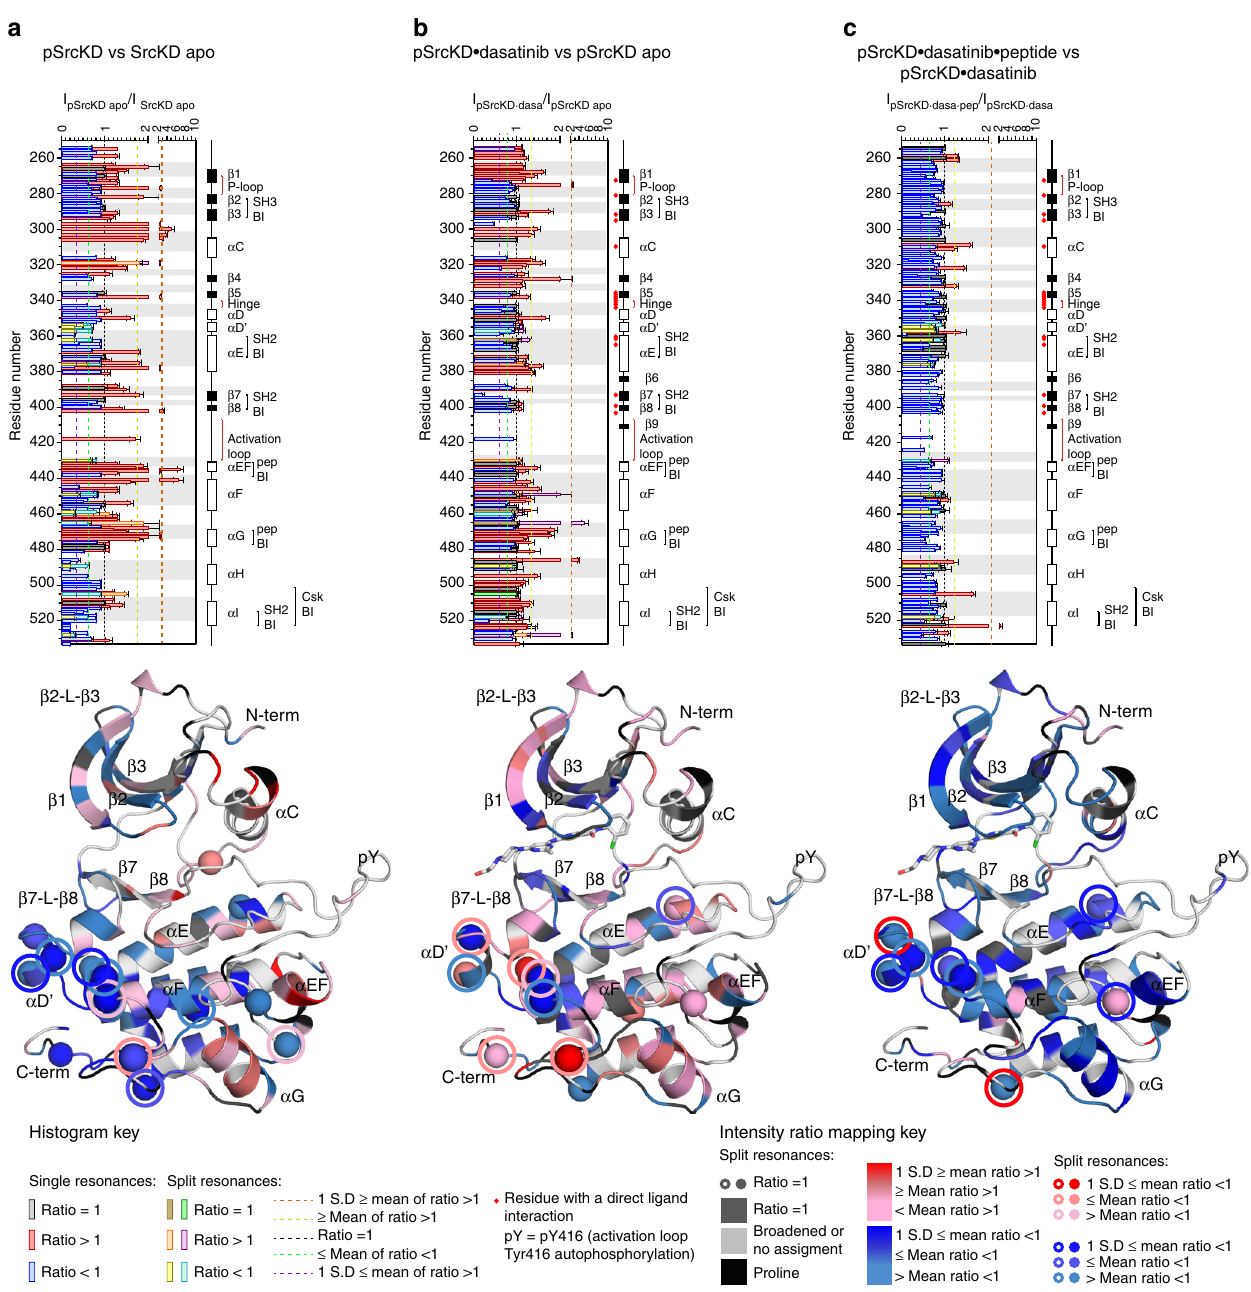
Fig. 6 Signals promoting the active conformation induce long-range dynamic changes. Backbone amide resonance intensity ratios of active SrcKD states formed upon: a activation loop autophosphorylation, ( b ) plus dasatinib, binding c plus substrate peptide binding, were analyzed by histograms and by structure mapping (PDB-entry 3G5D, 4YBJ, 4YBK) 30,31 to infer dynamic changes and interpreted as in Fig. 3. Spheres and circles denote split resonances (Supplementary Table 3). Activation loop autophosphorylation causes long-range sharpening and broadening affecting regulatory sites. Dasatinib induces additional sharpening to activation loop autophosphorylation in some regions, while in other regions it sharpens regions previously broadened by activation loop autophosphorylation. Peptide binding induces overall broadening, reverting the sharpening effects induced by dasatinib. Some intensity ratios for the second split resonance (circle) were either because of overlap or for clarity because its intensity ratio is similar to the fi rst resonance in terms of magnitude as shown in the